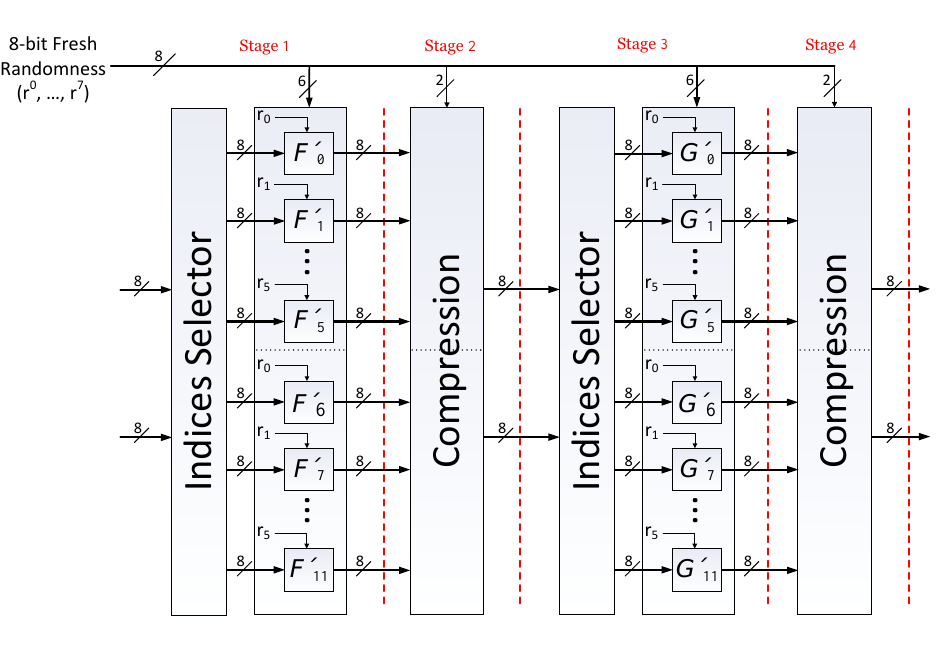
Figure 1: General structure of our 2-share masked AES S-box. Register stages are marked by red dashed